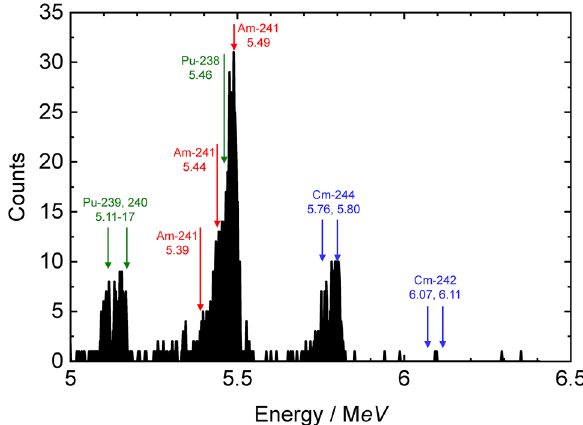
Figure 6. Alpha spectrum of the IP1.